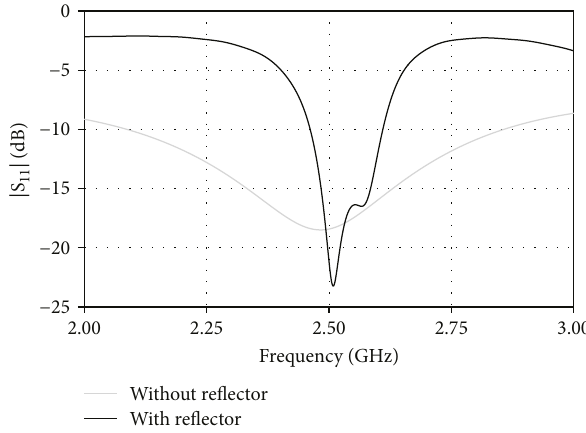
Figure 3: Simulated results achieved for the S corresponds to the simulation performed with re fl ector, while the grey curve is the result of the simulation performed without re fl ector.